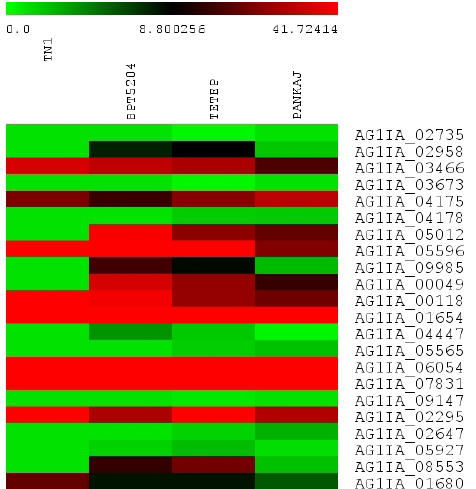
Figure 3. Heat map showing the expression of R. solani genes encoding transcription factors. The expression of transcription factor (TF) genes was analyzed in four rice cultivars. The values shown in bars at the top indicate FPKM of TF genes in different rice cultivars.